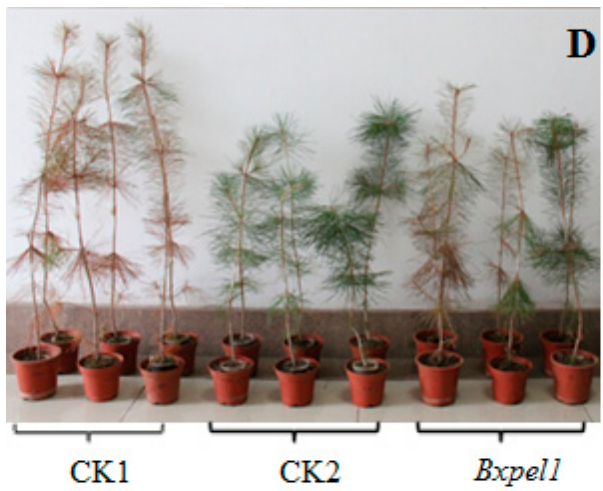
Figure 7. Wilting symptoms development of P. thunbergii after inoculation with B. xylophilus at 1 day ( A ); 10 days ( B ); 20 days ( C ); and 30 days ( D ). The pine trees were inoculated with PWNs that had been soaked in control solution (CK1), ddH 2 O (CK2), or Bxpel1 dsRNA ( Bxpel1